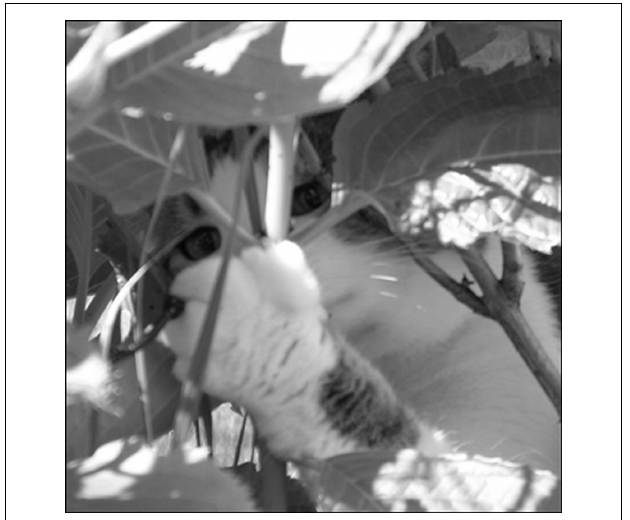
FIGURE 2 | Picture of a cute kitten stuck in a